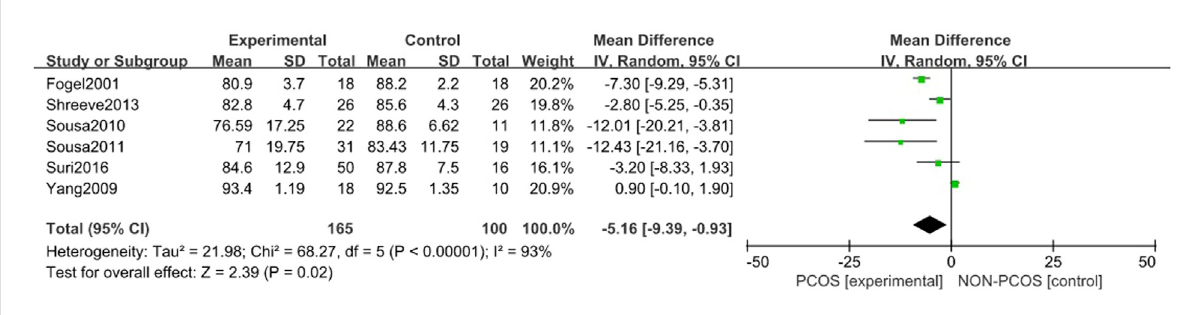
FIGURE 8 Forest plot of sleep ef fi ciency correlation between PCOS group and control group.